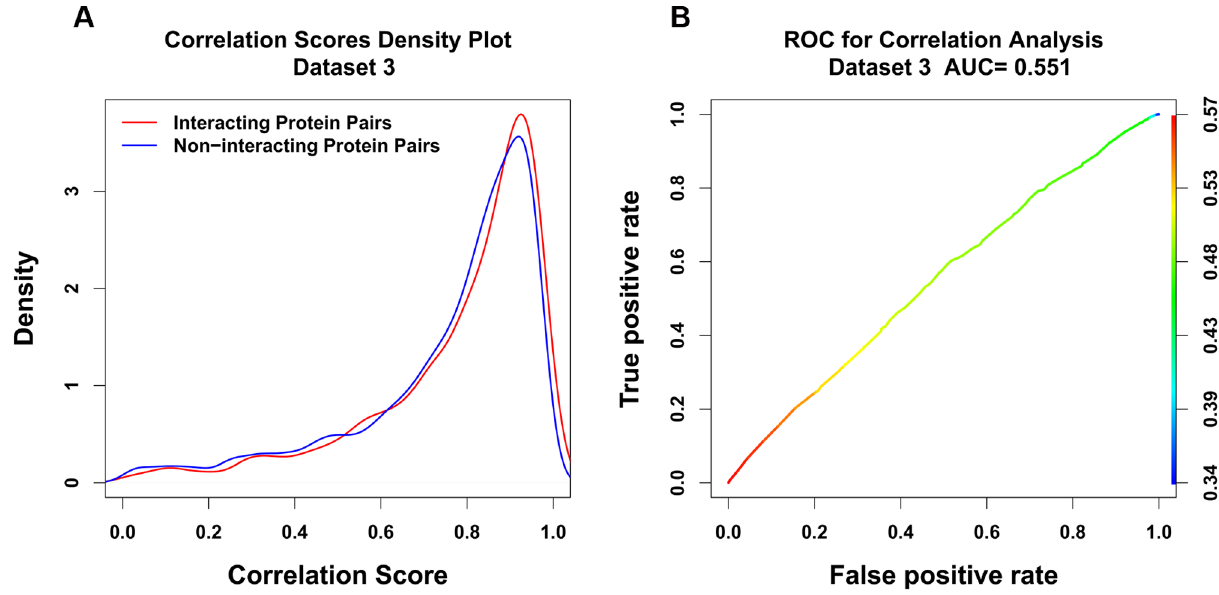
Figure 3. Density plot for correlation scores using Jones-Taylor-Thornton matrix for common interacting and non-interacting protein pairs from Dataset 3 (A) and the corresponding ROC plot (B). doi:10.1371/journal.pone.0081100.g003 stated in the method part. Figure 6 shows, for interacting pairs (6A) and for non-interacting pairs (6B) correlation scores vs. degree that have very low conservation and correlation.